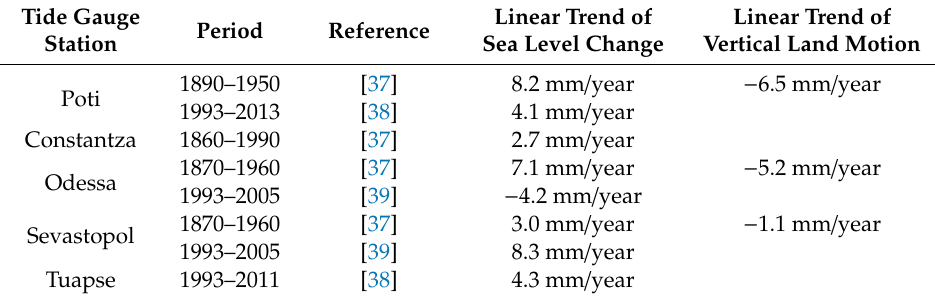
Table 5. Estimates of the rates of sea level changes at some tide gauge stations along the Black Sea coast (the data periods from [37] are approximately known, except for